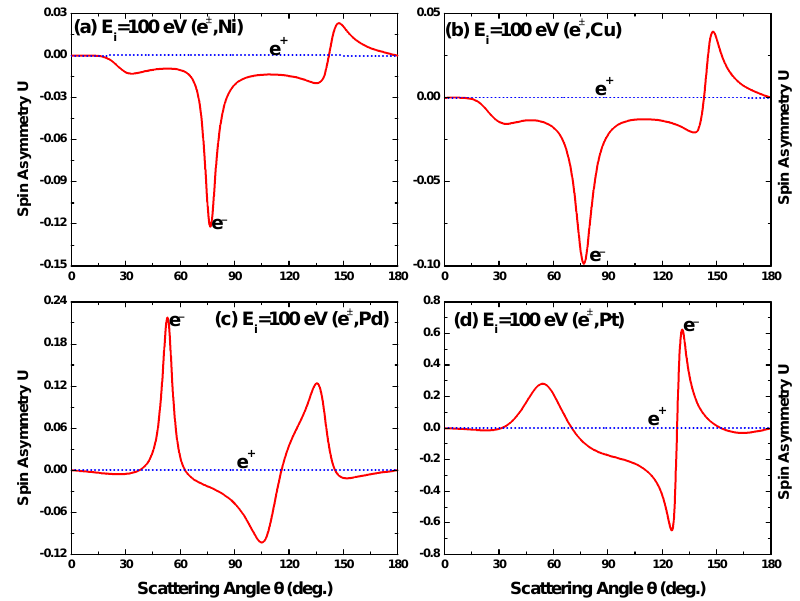
Figure 28. Angular variation of the spin asymmetry parameter U for e ± scattering from ( a ) Ni 58 , ( b ) Cu 63 , ( c ) Pd 108 , and ( d ) Pt 196 at a collision energy of 100 eV. (——-, red), electrons; ( · · · · · · , blue), positrons.